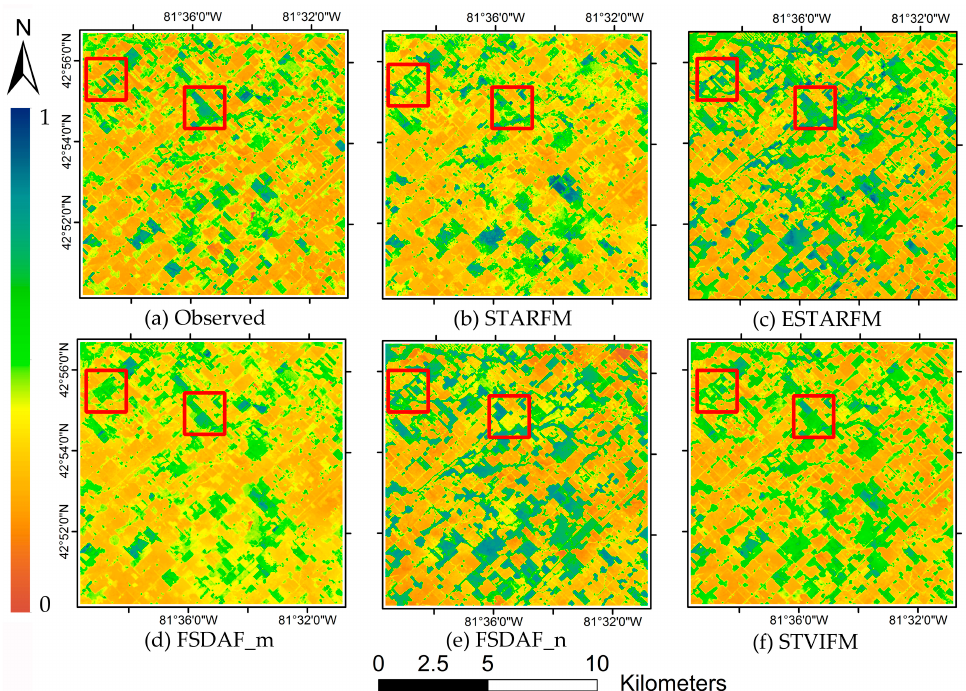
Figure 9. Comparison of the observed Landsat image ( a ); and the synthetic images based on: spatial and temporal adaptive reflectance fusion model (STARFM) ( b ); enhanced spatial and temporal adaptive reflectance fusion model (ESTARFM) ( c ); flexible spatiotemporal data fusion (FSDAF) ( d , e ); and spatio-temporal vegetation index image fusion model (STVIFM) ( f ), in Ontario, Canada. Red boxes show small-area land cover changes occurred on Landsat-8 images acquired at t p (6 May 2014) and t n (7 June 2014).